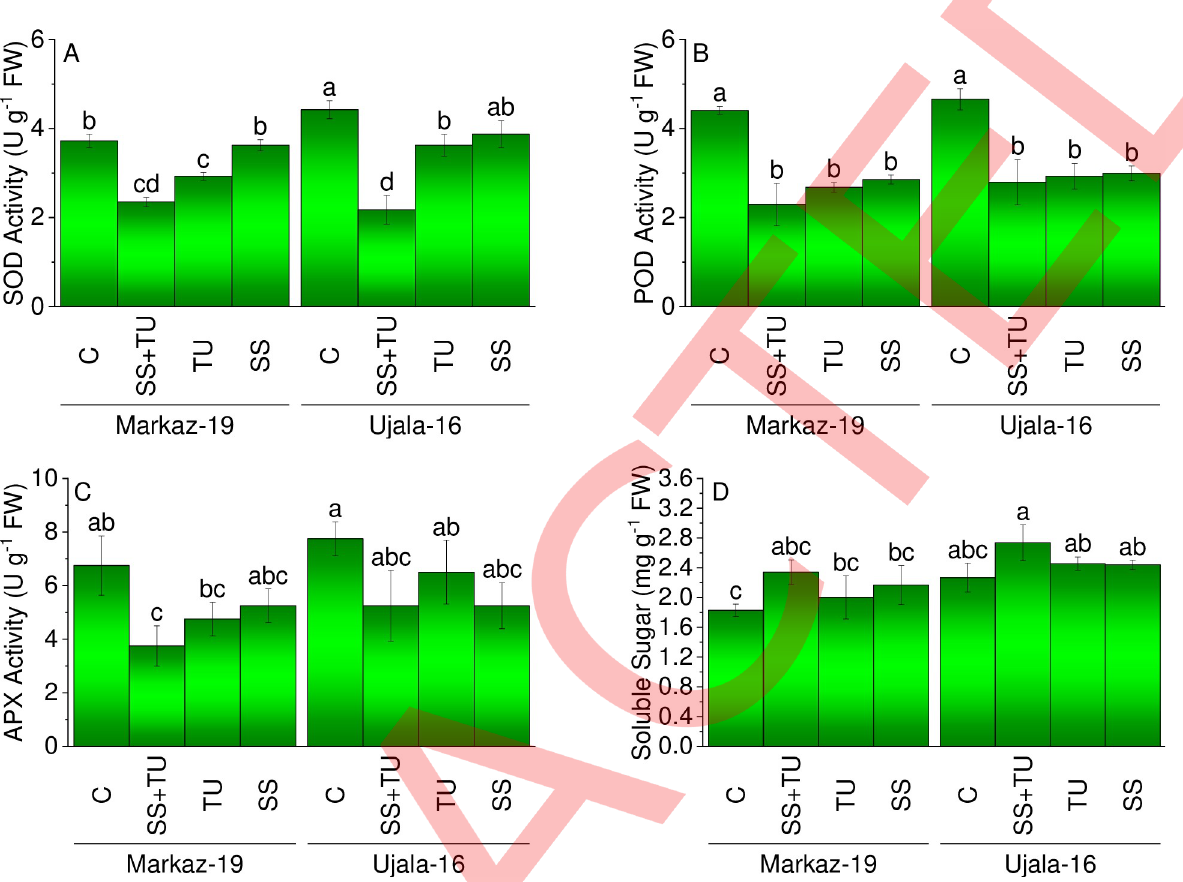
Fig 3. Influence of different treatments on SOD (A), POD (B), APx (C) and soluble sugar (D) contents of two wheat genotypes (Markaz 19 and Ujala 16) after 35 d of the growth period in pots. All values are the mean of 4 replicates. Error bars are showing ± standard error. Different letters on bars are significantly different at p < 0.05 according to LSD test. C: Control, SS+TU: sewage sludge+thiourea, TU: thiourea, SS: sewage